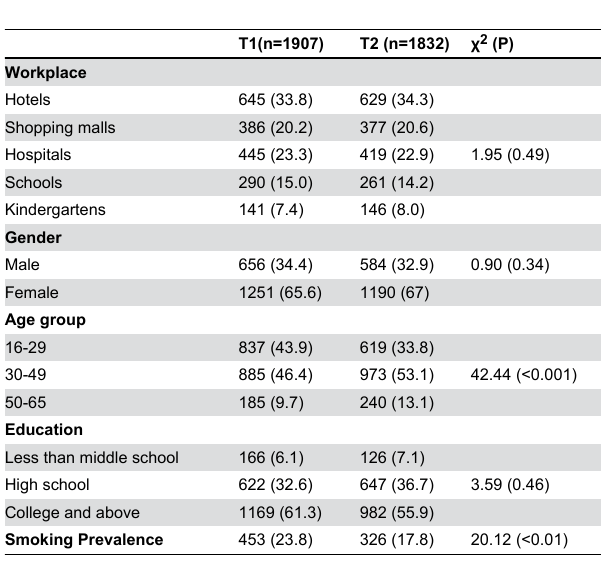
Table 1. Workplace and demographic characteristics of participants